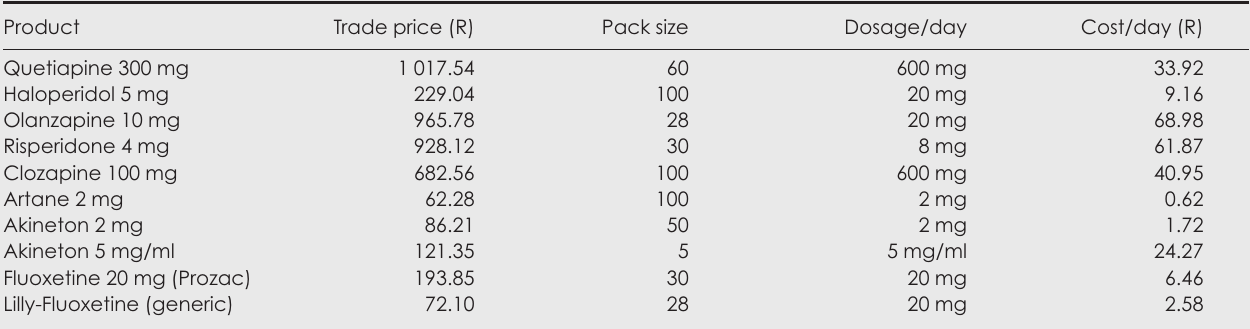
Table III. Medication costs in South